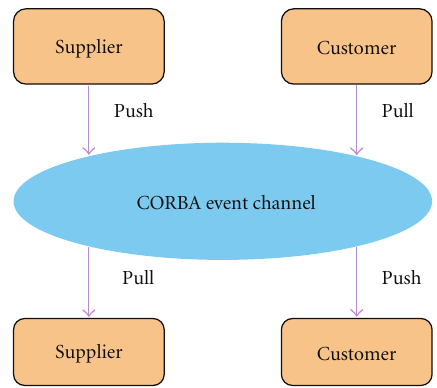
Figure 3: Event channel architecture.